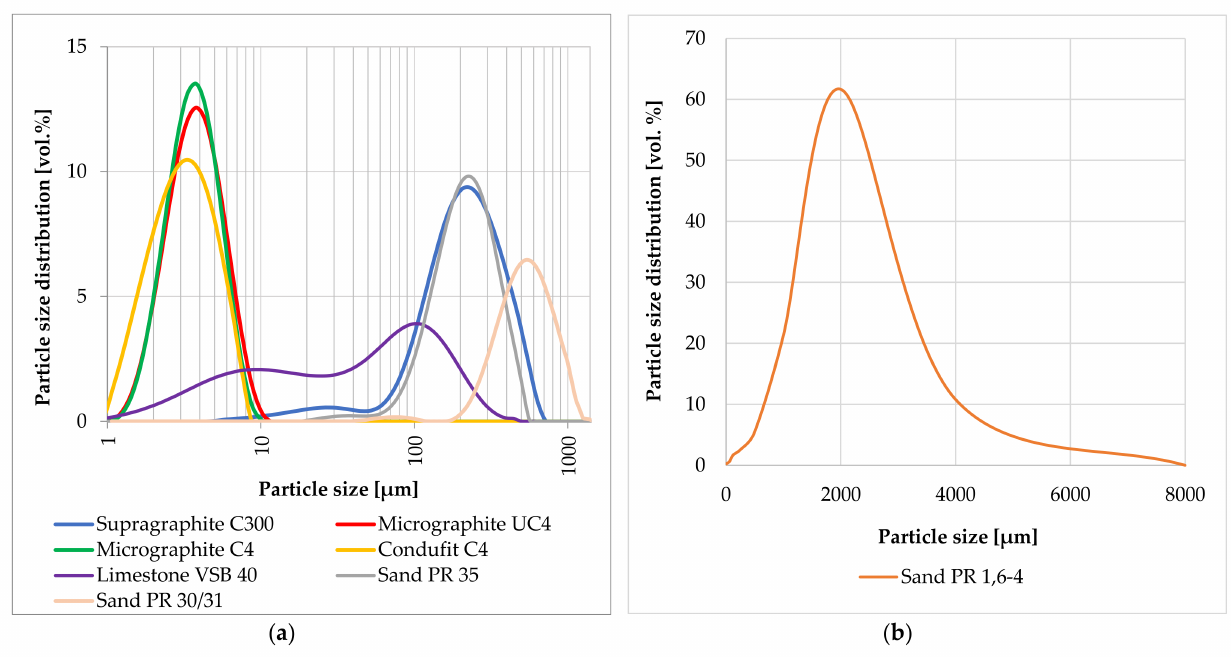
Figure 2. Distribution curve of materials used with particle size: ( a ) below 1 mm; ( b ) above 1